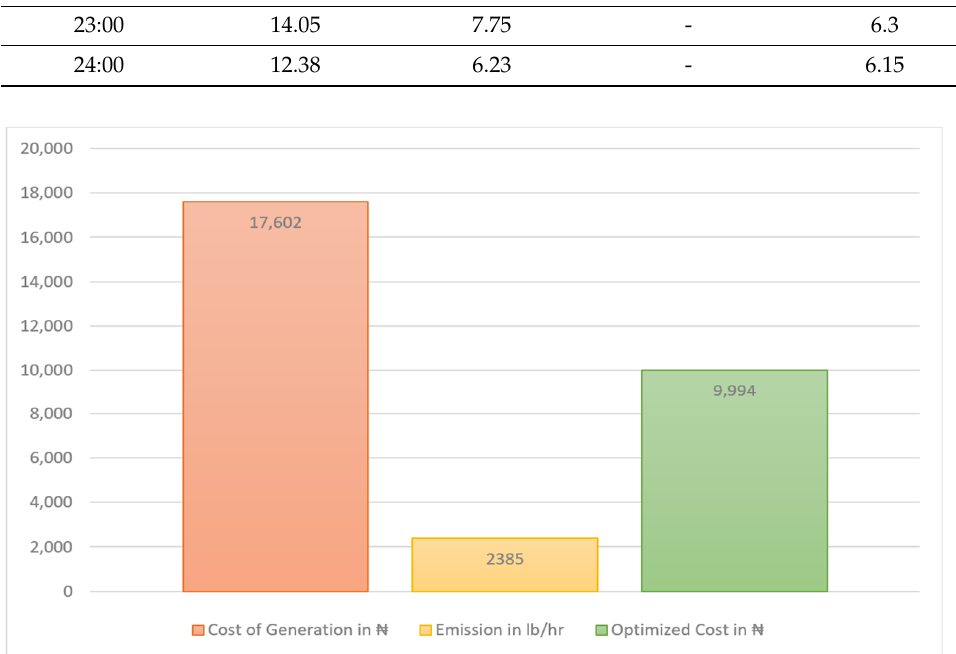
Figure 5. Case 2: Power output variation from diesel and wind turbine generators.